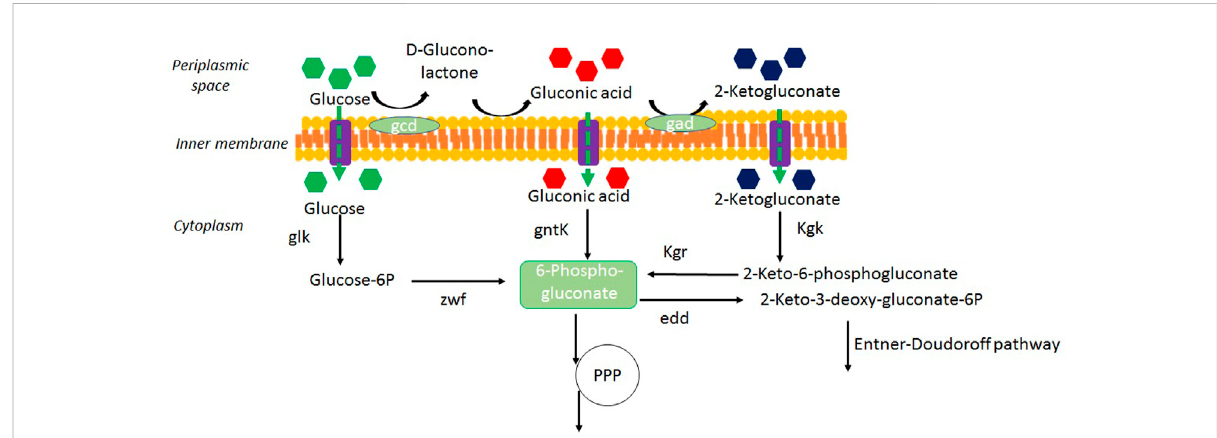
FIGURE 5 Alternativepathwaysofgluconicacidformationfromglucosein H.boliviensis DSM15516.Glucoseutilizationcanfollowthedirectoxidativepathwayin theperiplasmicspacetogluconicacidorenterthecytoplasmandfollowthephosphorylativepathwaytoproduceglucose-6-P.Theabbreviationsstandfor PPP,thepentose-phosphatepathway;gcd,glucosedehydrogenase;gad,gluconatedehydrogenase;gntK,gluconokinase;kgk,2-ketogluconokinase;kgr,2- keto-6-phosphogluconate reductase; zwf, glucose-6P dehydrogenase; glk, glucokinase; edd, glucose-6P